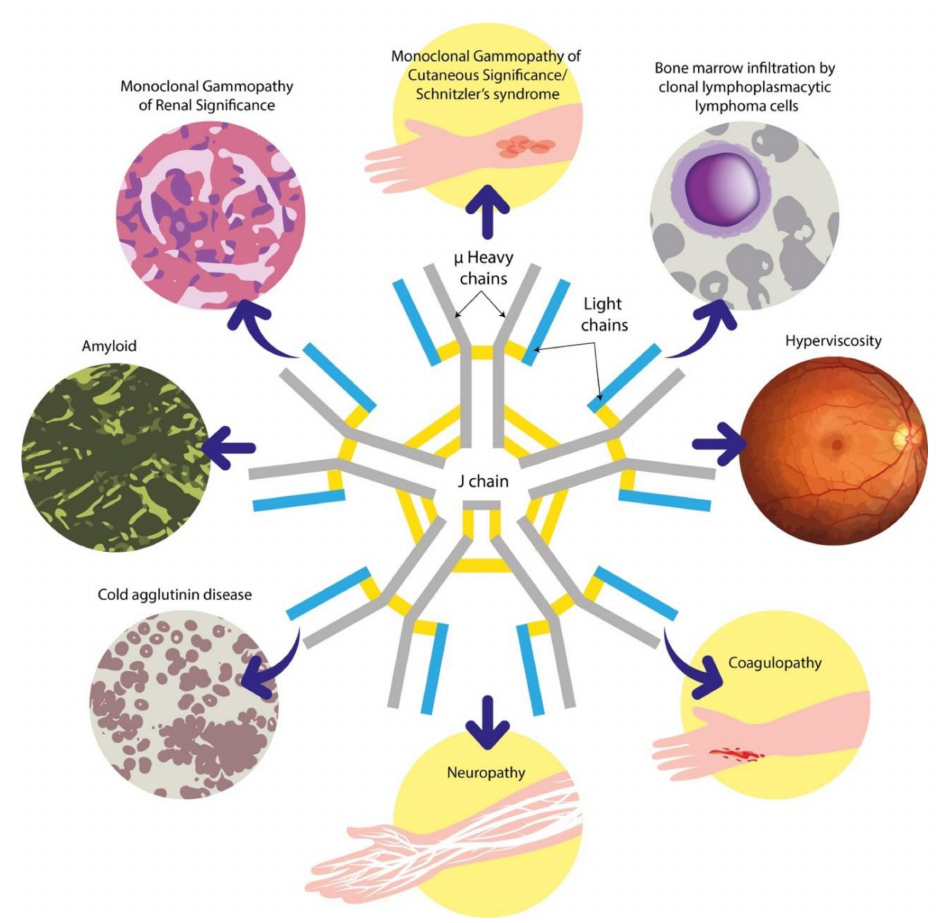
Figure 1. An overview of the clinical manifestations associated with IgM gammopathies. The high molecular weight of the IgM pentamer depicted at the centre is key to the unique behaviour of this paraprotein. IgM = immunoglobulin